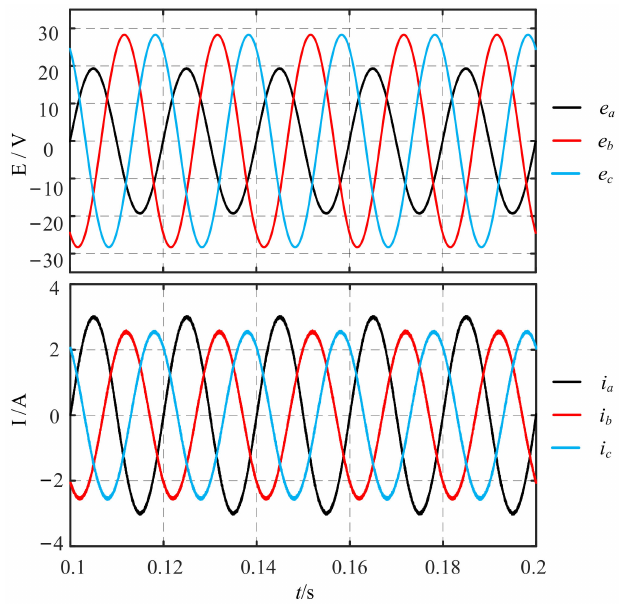
Figure 7. Waveforms of novel FCS-MDPC of novel